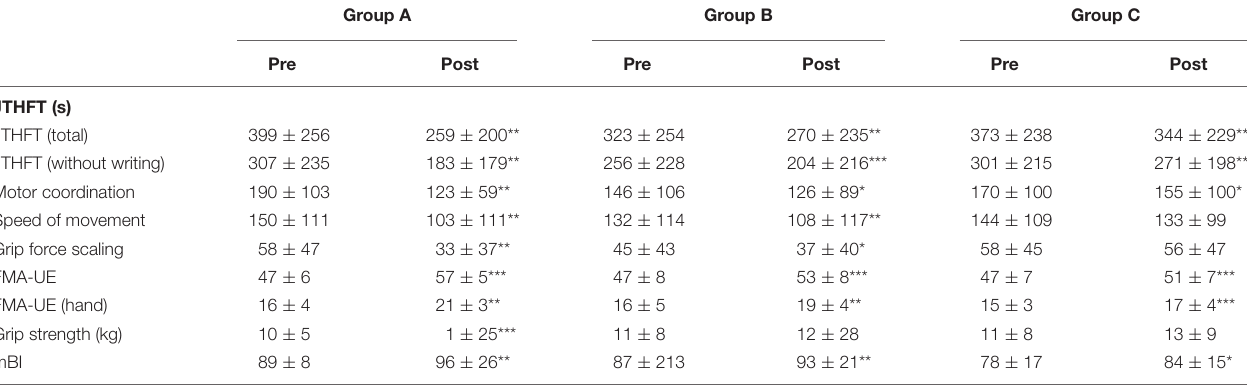
TABLE 2 | Behavioral outcome scores at baseline and post-intervention (mean ± SD). Group A Group B Group C Pre Post Pre Post Pre